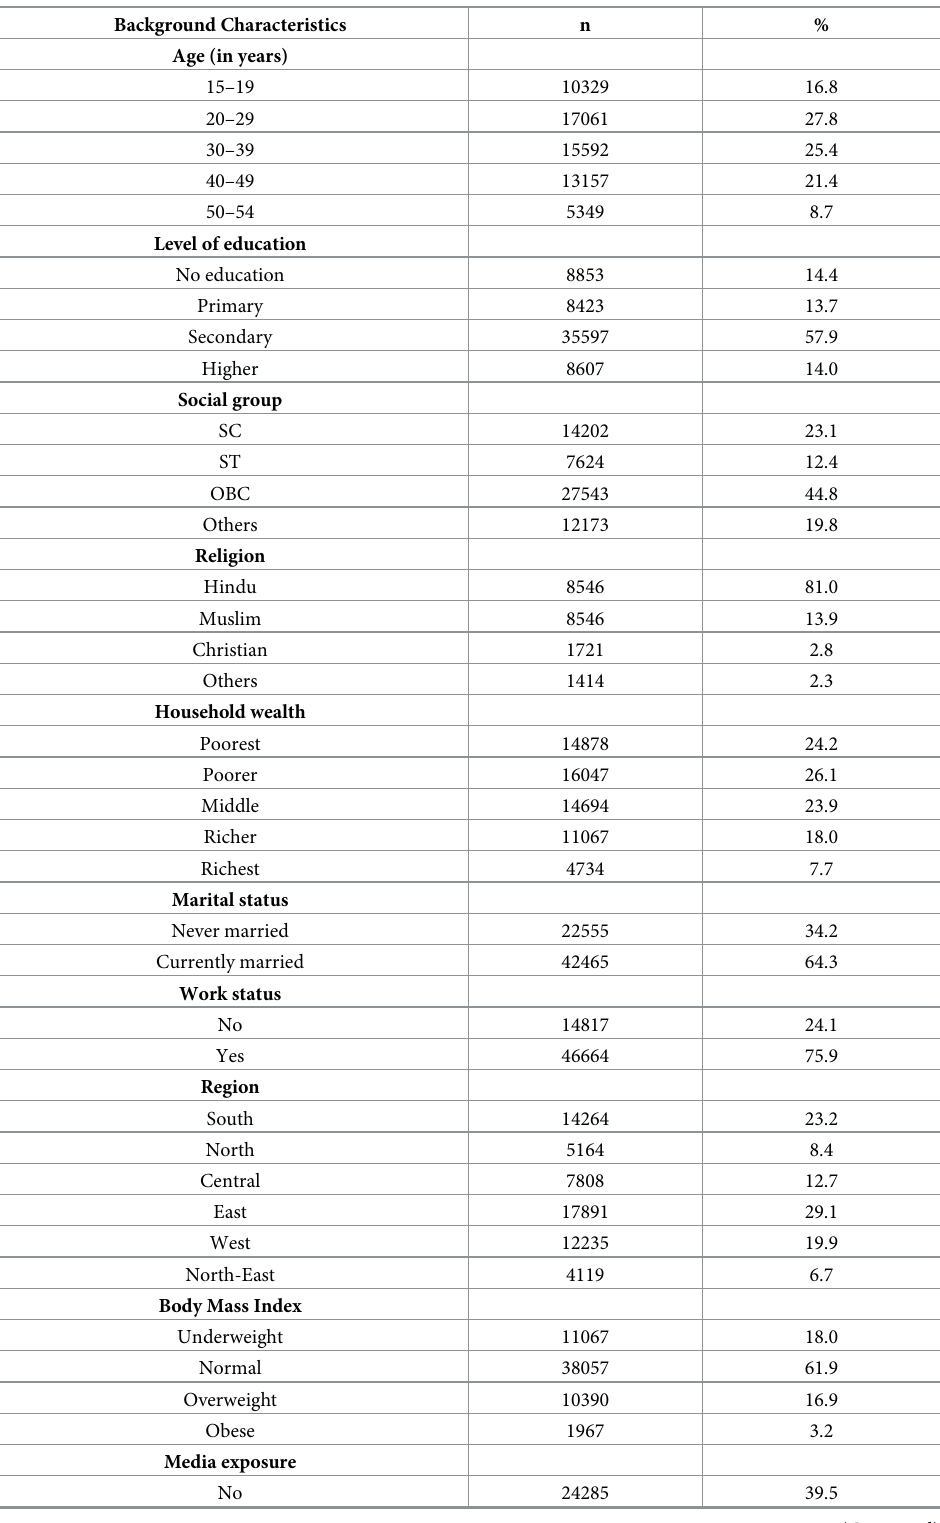
Table 2. Profile of the respondents, India,